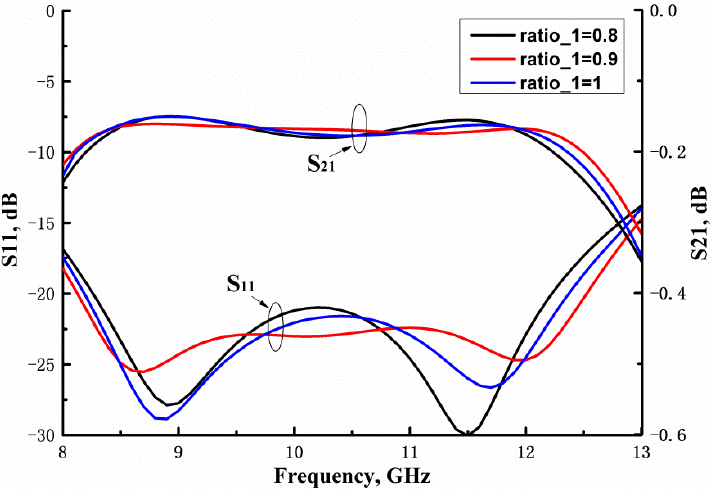
Figure 4. Simulated S-parameters of waveguide-to-CPW with varying parameters.